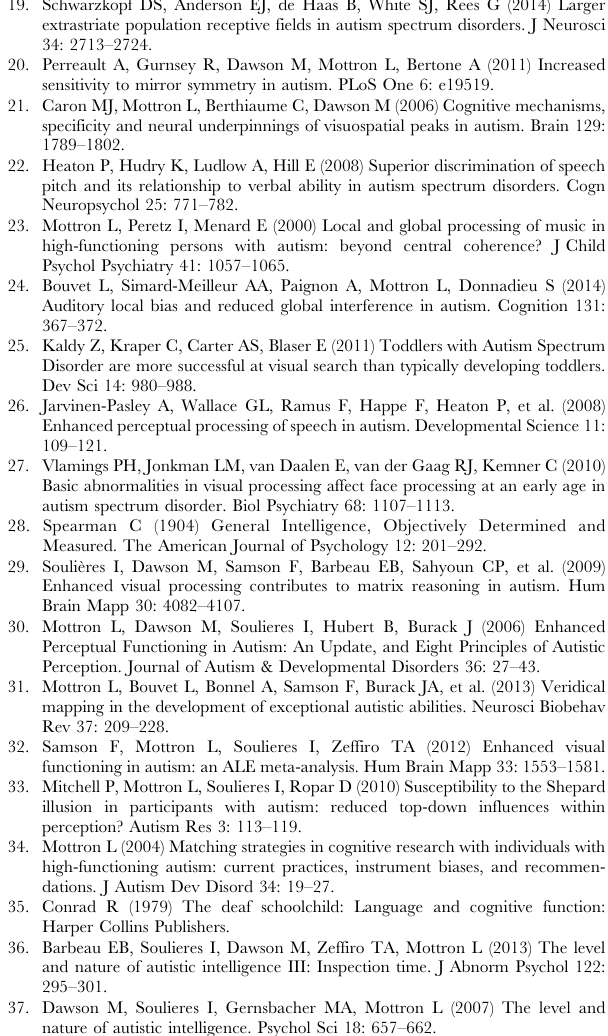
Figure S1 Task performance – Intelligence relation- ships: groups differences. Raw performance for each experimental task (y axes) plotted on intelligence level (x axes). Autistic individuals are in green, TD controls are in blue. These graphs represent the statistics found in Table 2. The statistics presented in Table 3 can also be visualized on this figure by looking at differential group performances for intelligence levels at 0SD and + 1SD. Note that the graph for the block design task does not exactly illustrate the statistics from Table 2 and 3 since a 2D